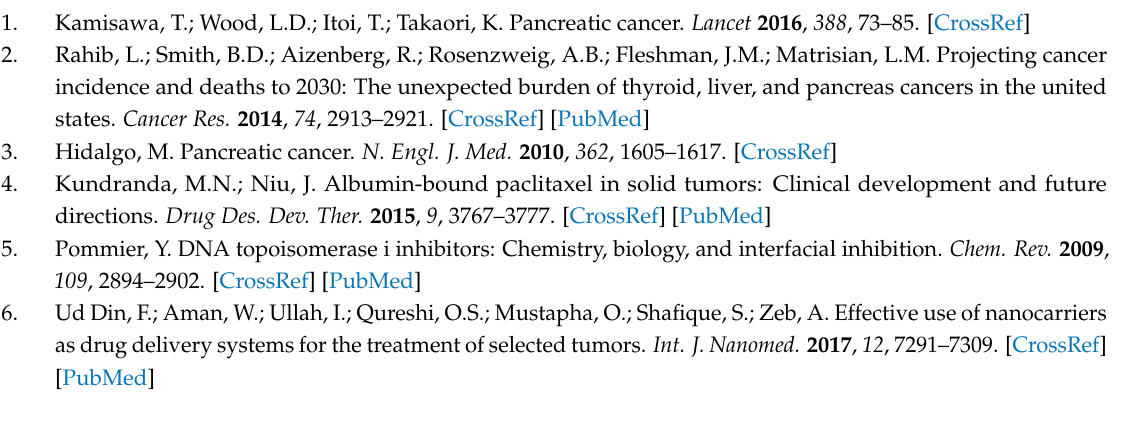
Figure 5. ( A ) Cellular uptake of Lip-1 (grey diagonal hatched lines), Lip-5 (grey vertical hatched lines), and Onivyde ® (grey bar) in PANC-1 and INS-1 cells after 1-h incubation with human plasma (HP). ( B ) Mean fluorescence intensity of Lip-1 (grey diagonal hatched lines), Lip-5 (grey vertical hatched lines), and Onivyde ® (grey bar) in PANC-1 and INS-1 cells after 1-h incubation with human plasma (HP). Statistical significance was evaluated using Student’s t -test: * p < 0.01; ** p < 0.005 (no asterisk means lack of significance).